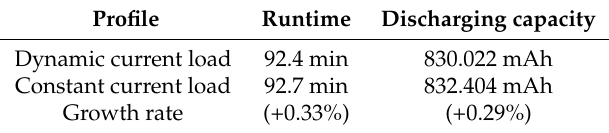
Figure 16. ECM simulation results: ( a ) load current; ( b ) battery voltage; and ( c ) discharging capacity. Table 5. ECM simulation results of two different profiles with a 0.63 C average